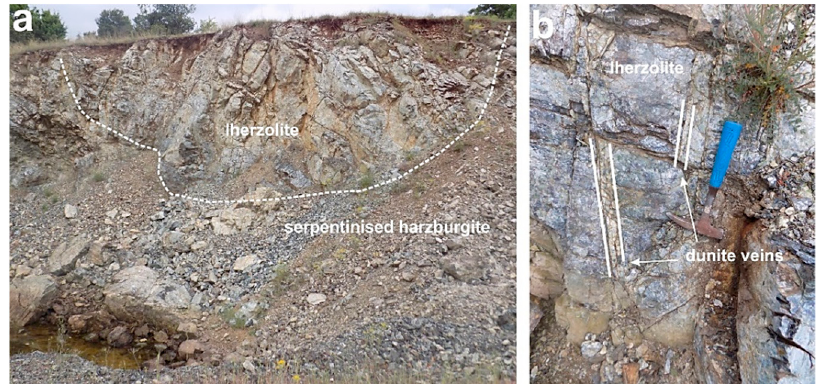
Figure 3. Views of the studied peridotite: ( a ) Irregular lherzolite body (~10 m) surrounded by serpentinised harzburgite; ( b ) dunite veins penetrate a lherzolite body.